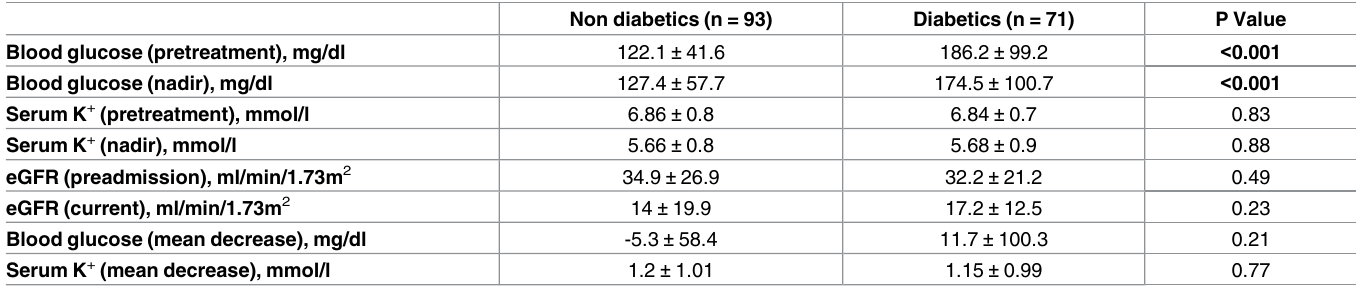
Table 3. Comparison of analytical parameters between diabetics and non-diabetics. Blood glucose (pretreatment),